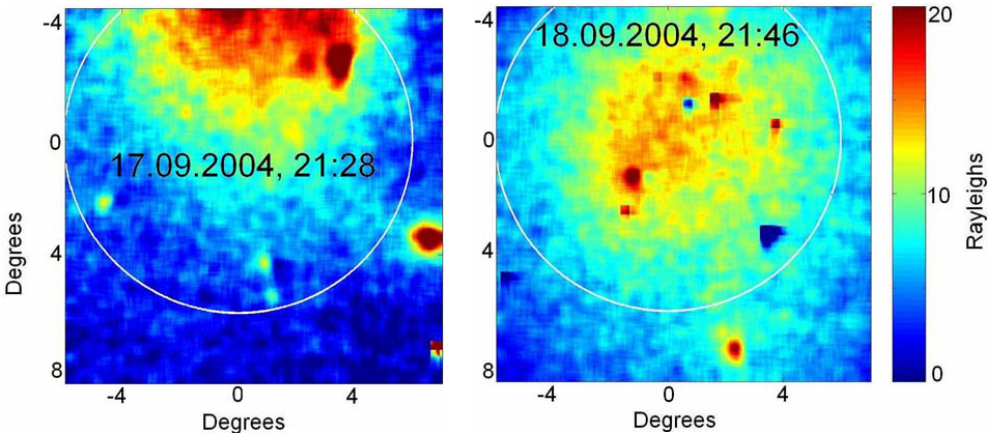
Fig. 4. Images of artificial airglow obtained on 17 September 2004, for an HF beam zenith angle of 12 ◦ S (left panel) and on 18 September 2004, for an HF beam zenith angle of 16 ◦ S (right panel). North and east are at the bottom and right of each